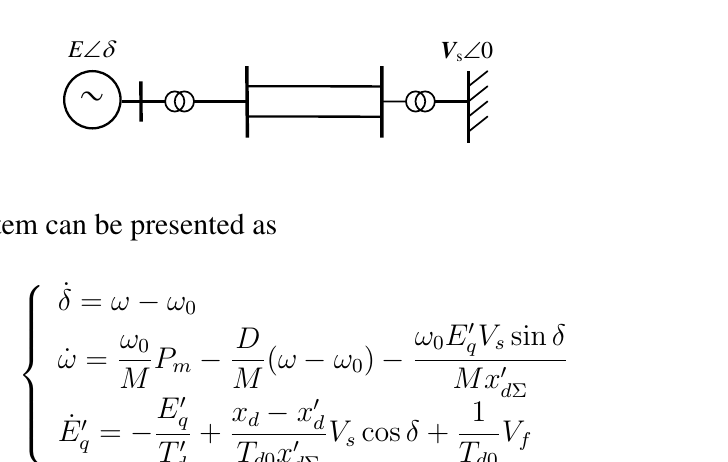
Figure 1. the configuration of a single machine infinite bus power